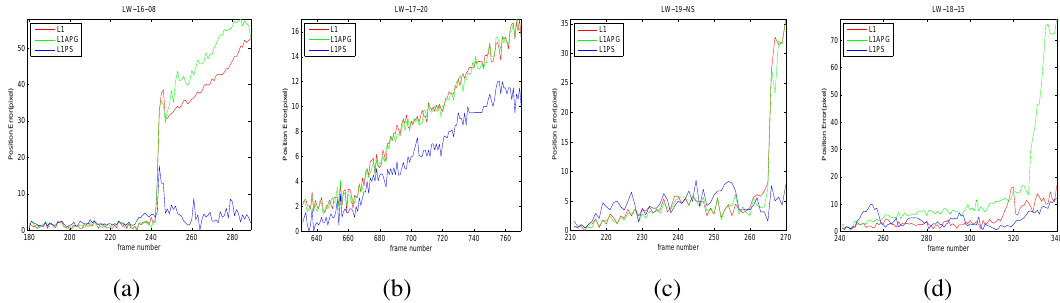
Figure 5. Quantitative comparison of three trackers in terms of position errors (in pixel).